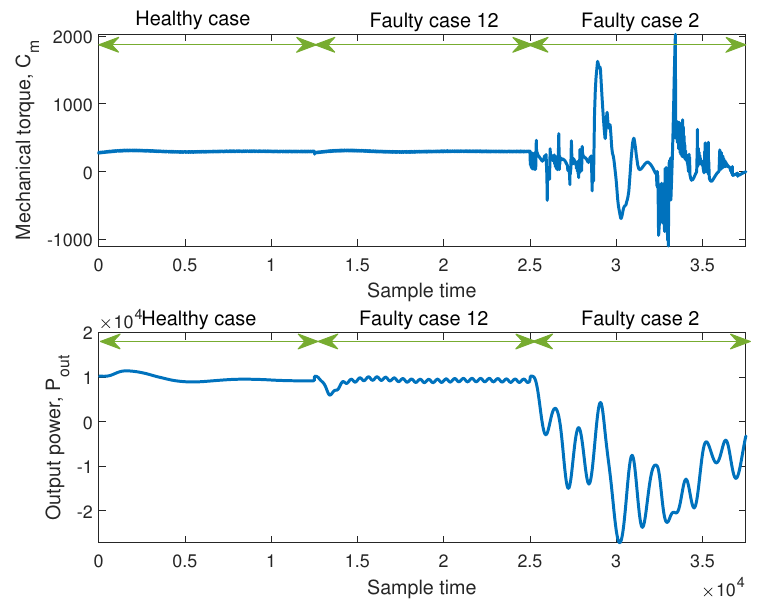
Figure 10. Input torque and output power for different cases.